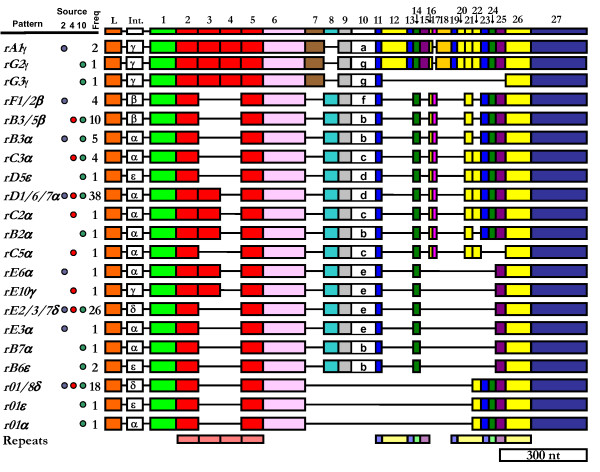
Repeat-based alignment of the 185/333 genes. The alignment was optimized for repeats and 27 elements (colored boxes) were defined. Gaps due to missing elements are indicated by horizontal black lines. There are 17 different exon element patterns, which, when combined with the intron types (Figure 3), form a total of 21 unique gene patterns. The frequency (Freq) of patterns indicates how often the pattern was identified. The source animal for each pattern is indicated by the presence of a colored dot as in Figure 2. The subtype of element Er10 (which corresponds to Ex15, Figure 2A) is indicated by the letter in the box. Intron types are unaffected by this alignment because they do not have repeats; their designation corresponds to that shown in Figure 3.